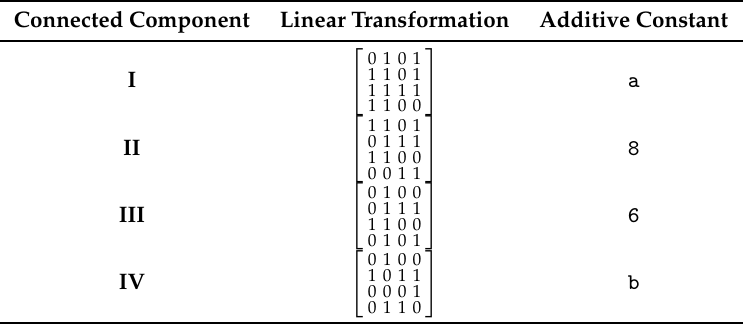
Table A11. Affine transformations on connected